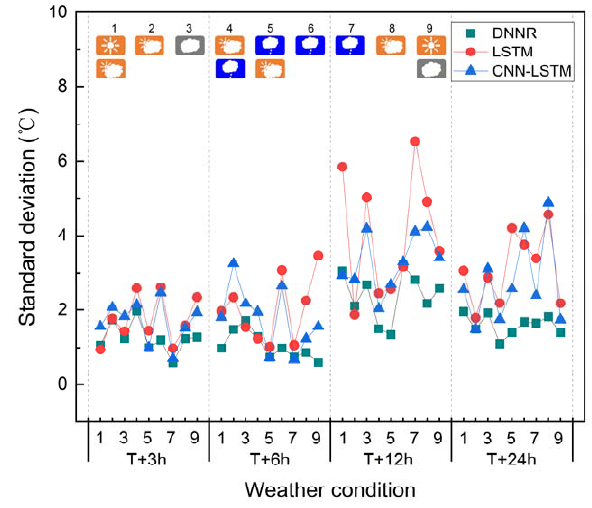
Figure 15. Statistics of the error distribution between the predicted value of the best model and the actual value for the humidity of Greenhouse A. The ST of the errors of the three models under different weather conditions are shown in Figure 16, for three models, the ST of the DNNR model is also the smallest under different weather conditions, and the ST of three models increase with the training set time horizon, the ST of three models are the biggest at T+12 time point under different weather conditions, which means that the DNNR was the best predictive model among the three models, and the DNNR model was not suitable for parameters prediction 12 h ahead.